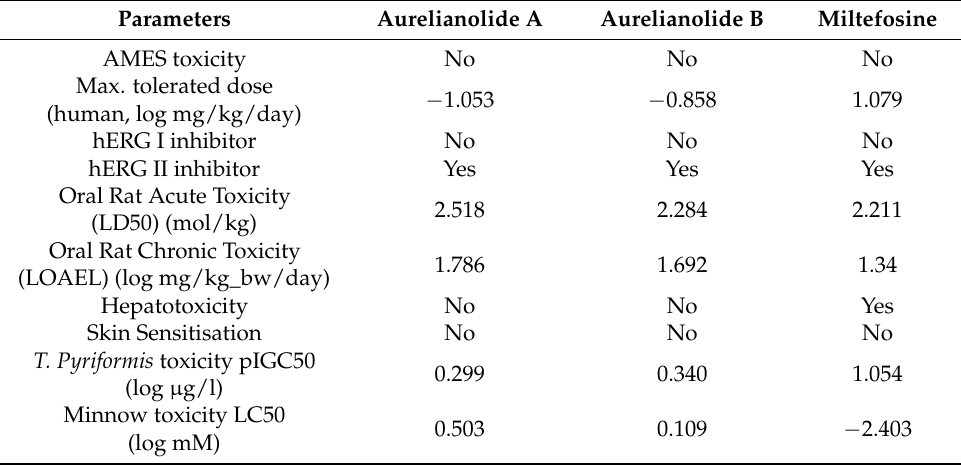
Table 4. In silico Toxicity of Aurelianolides and miltefosine using the pkCMS